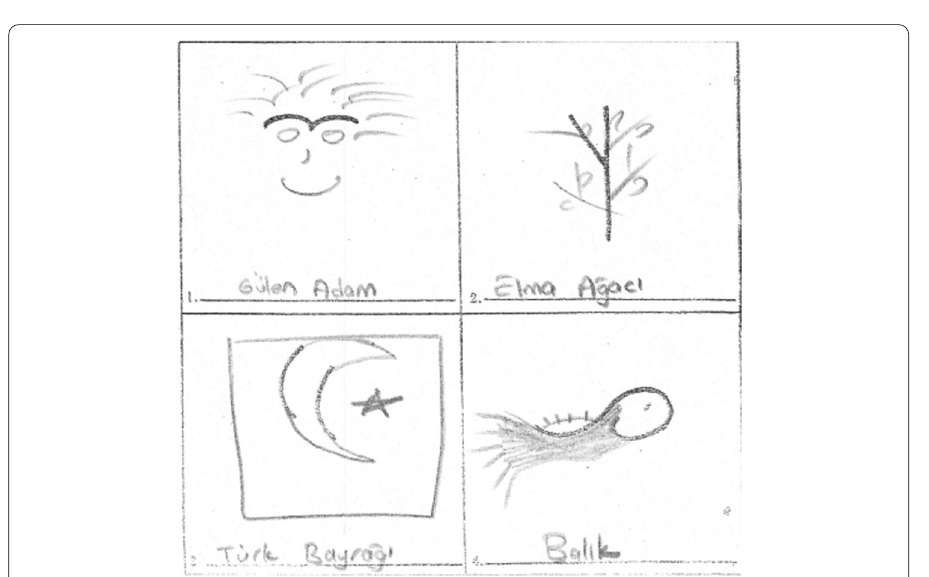
Fig. 4 Pre-test responses of the figure